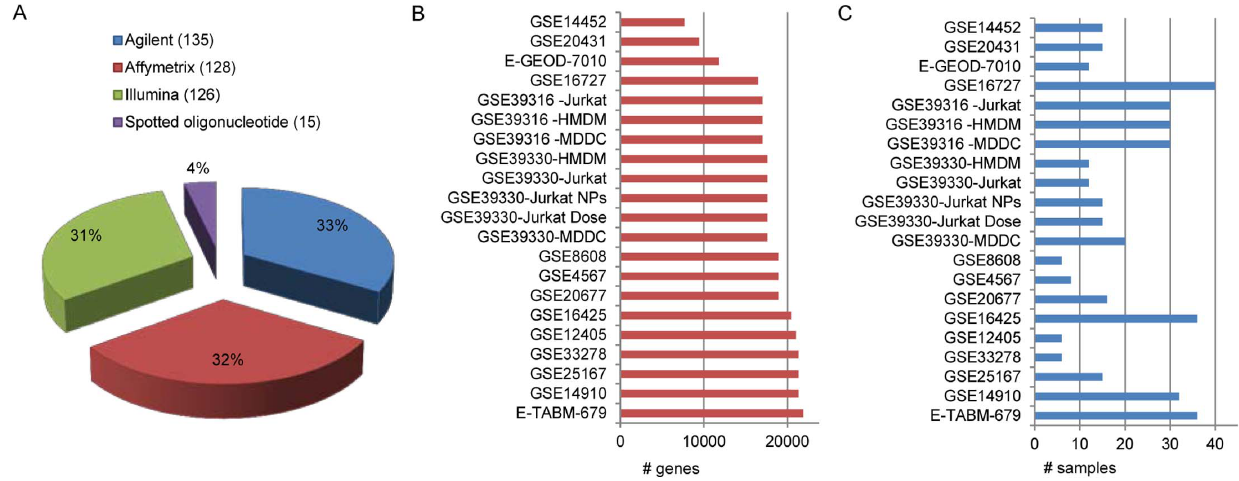
Figure 4. Data in NanoMiner. A) The samples in NanoMiner measured with different platforms, B) Number of genes measured in the datasets in NanoMiner, C) Number of samples in each dataset.